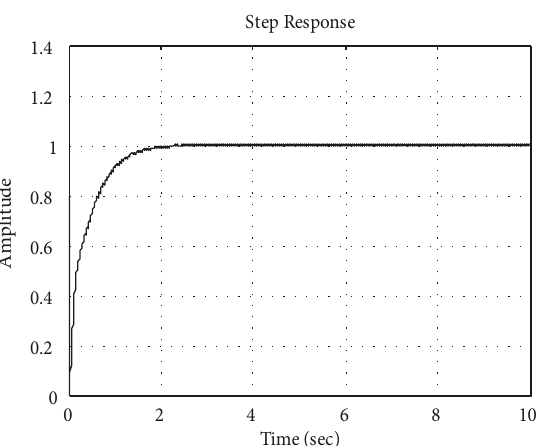
Figure 30: Response curve at 0.1 times β